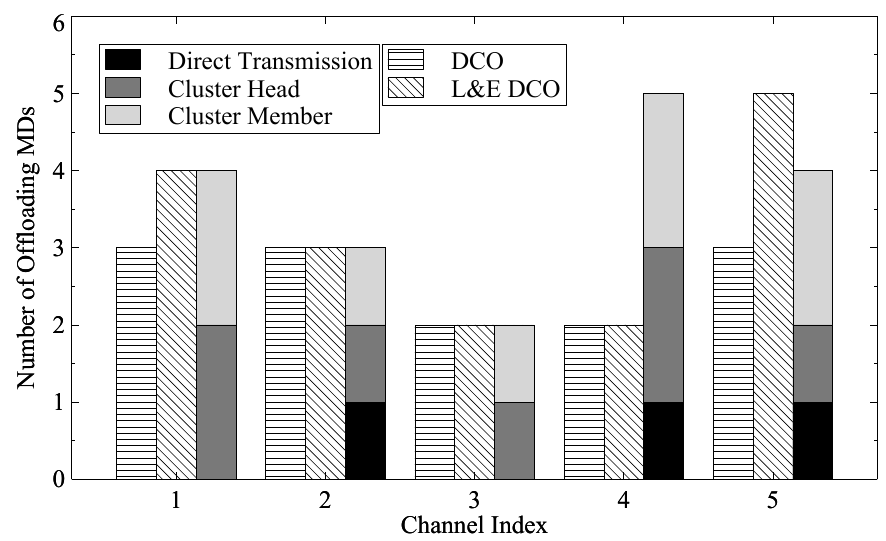
Figure 5. The distribution of 30 MDs in each channel.